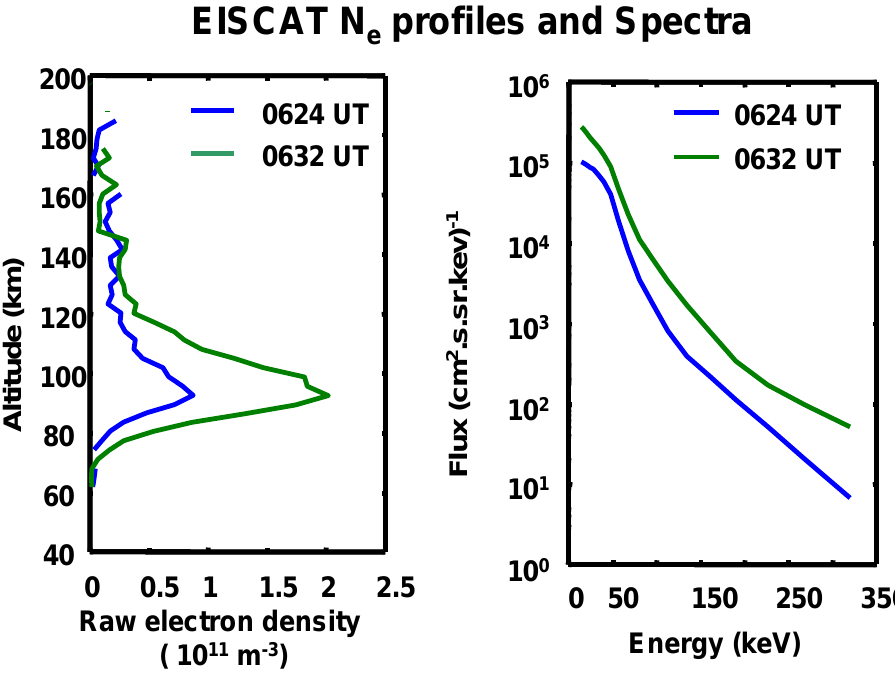
Fig. 10. The first panel contains EISCAT measured electron density profiles for two times close to the onset of the event. The second panel shows the corresponding modelled energy flux spectra, calculated from the profiles using the ZABMOD method. Note the hardening of the spectrum from 06:24UT to